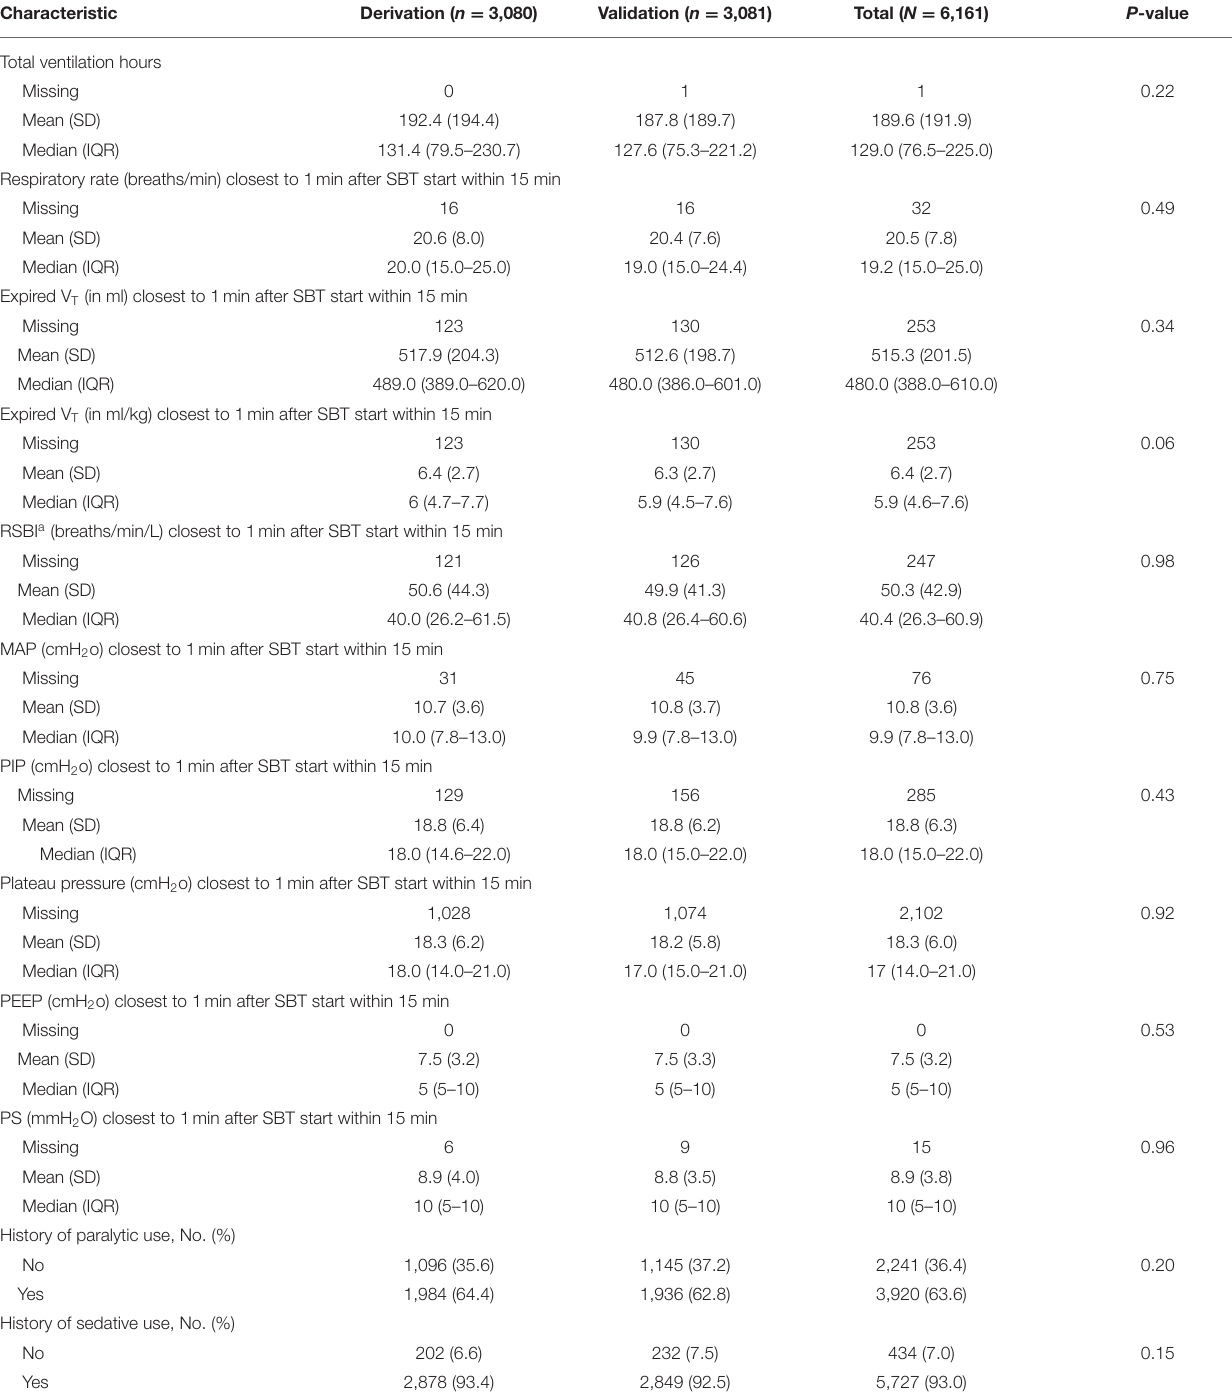
TABLE 2 | SBT and MV data for derivation and validation